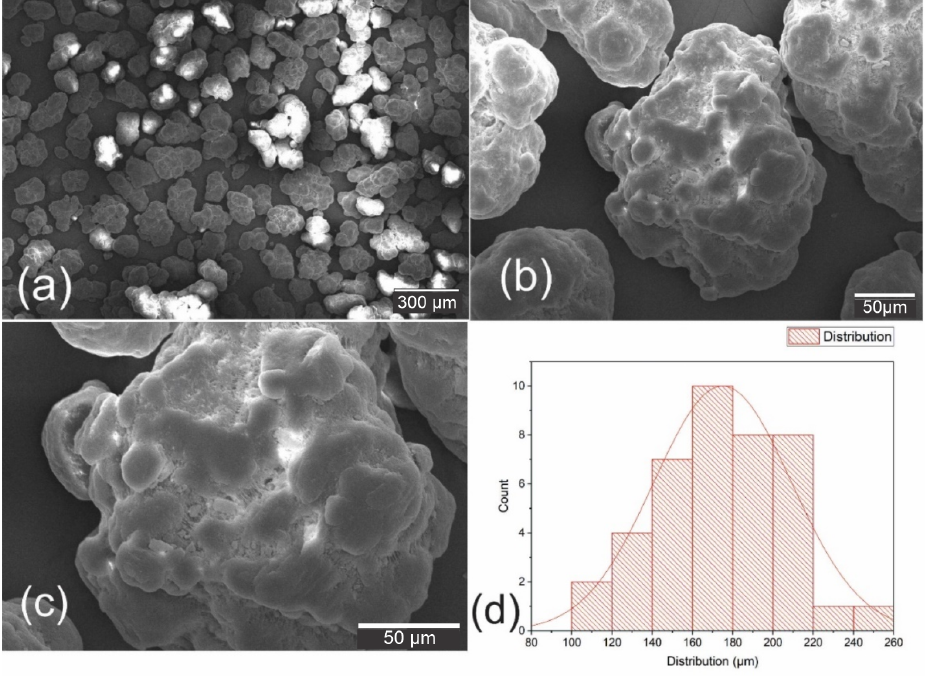
Figure 9. ( a ) UHMWPE powder—50 × magnification. ( b ) UHMWPE powder—300 × magnification. ( c ) UHMWPE powder—600 × magnification. ( d ) Normal distribution of UHMWPE particles.